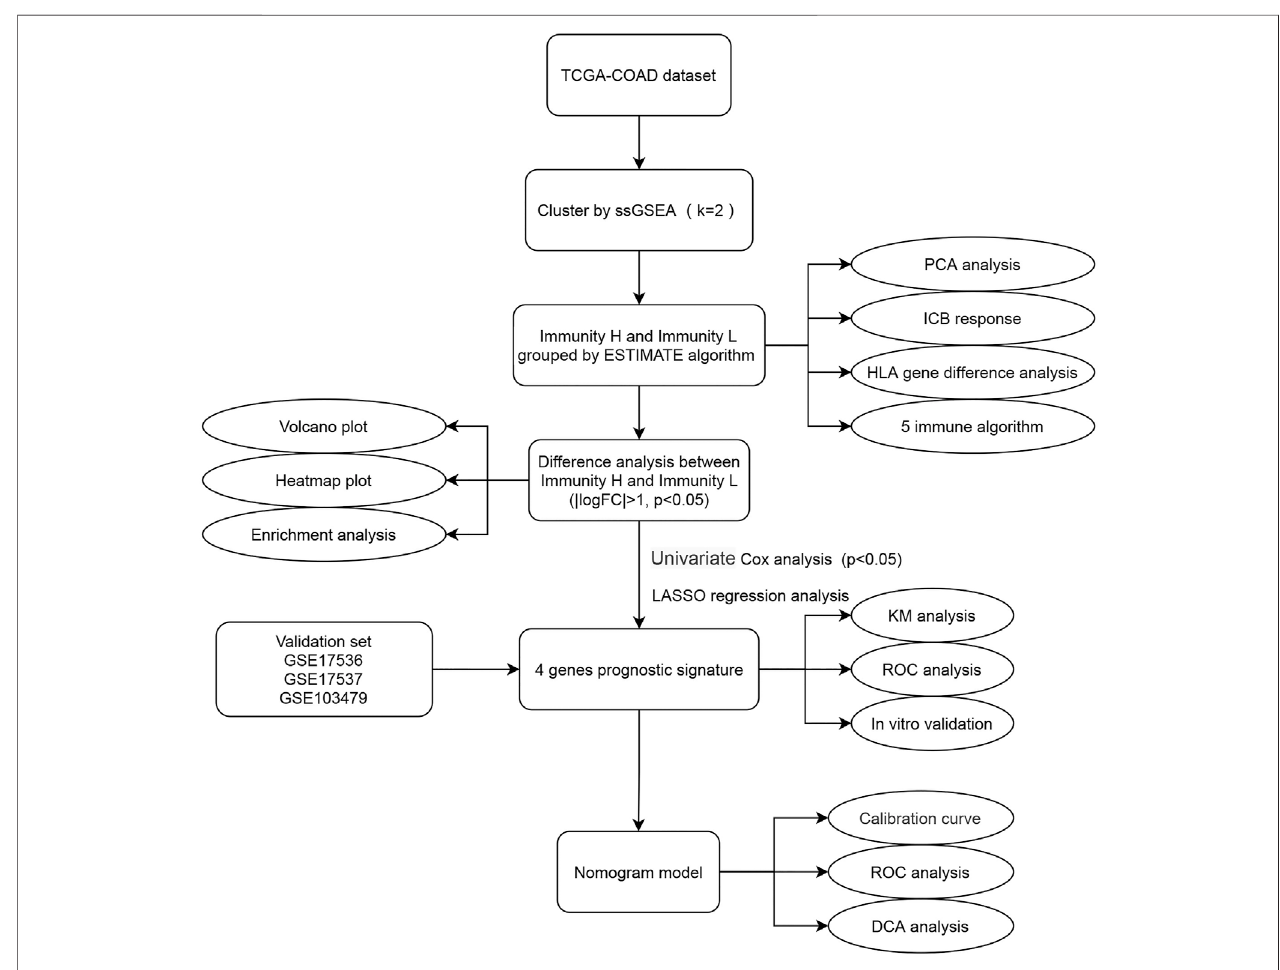
FIGURE1| Flowchartofthisstudy.Thesquareelementrepresentstheresearchprocess,andtheovalelementrepresentsthespeci fi cresearchmethodandresult.